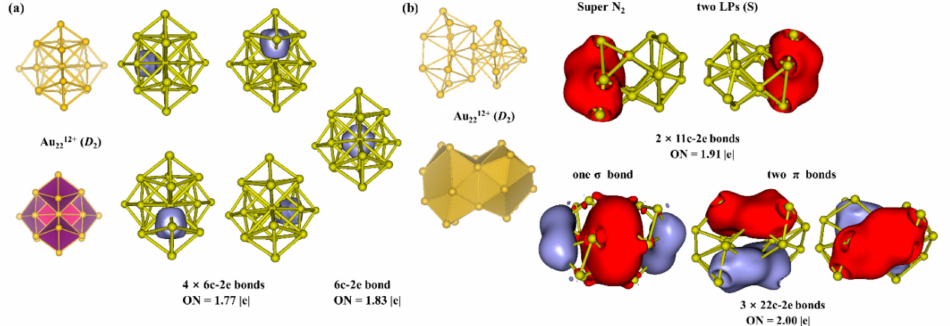
Figure 5. ( a ) Structure, superatom-network model and AdNDP localized natural bonding orbitals of Au 2212 + core. ( b ) Structure, superatomic molecular model and AdNDP localized natural bonding orbitals of Au 2212 + superatomic molecule.